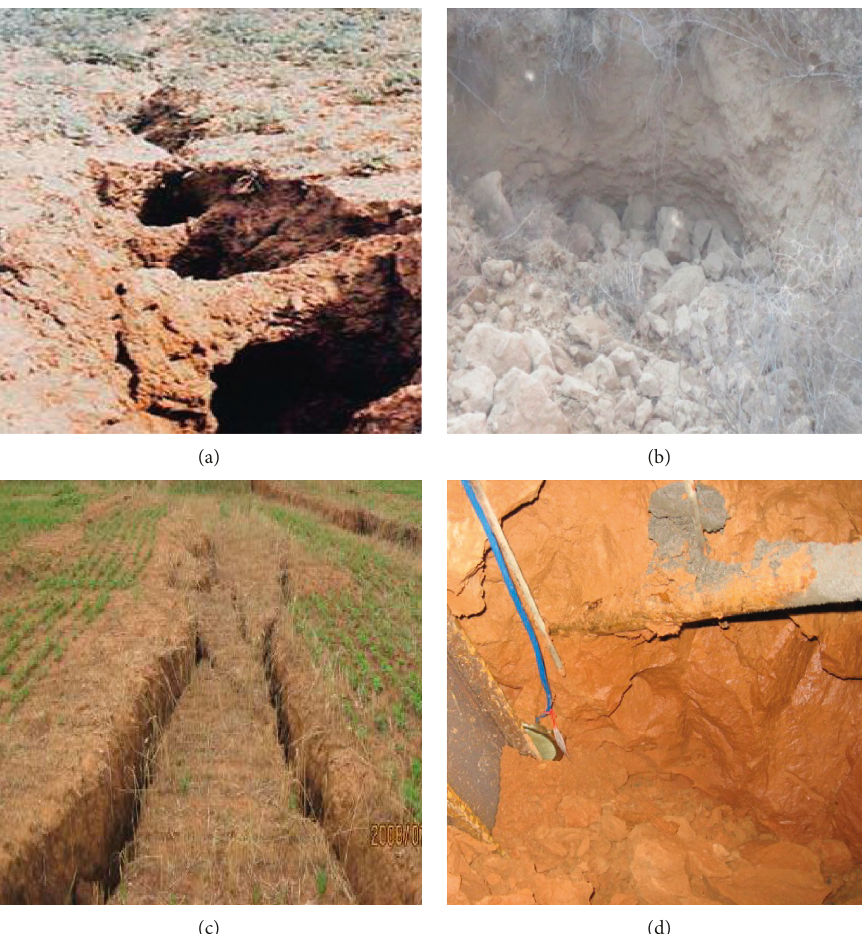
Figure 6: The geological hazard of the water-rich loess tunnel: (a) water sinkhole in ground surface, (b) loess settlement cave, (c) surface crack, and (d) surrounding rock argillization.